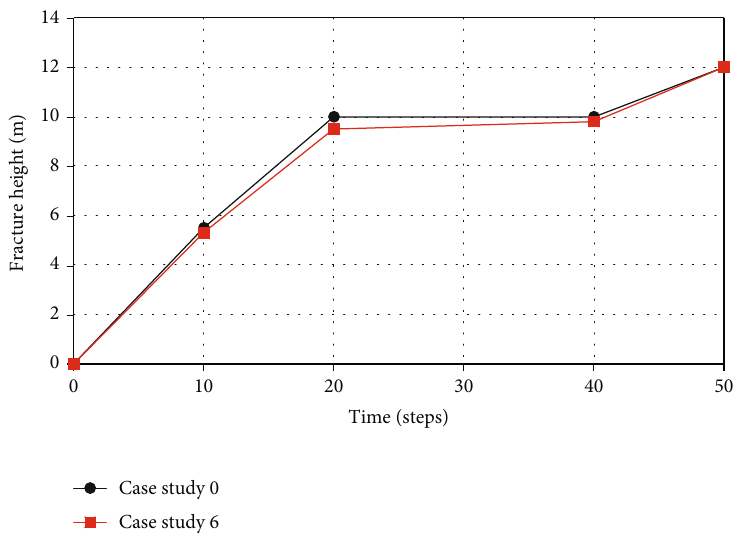
Figure 20: Comparison of fracture height between case 0 and case 6.